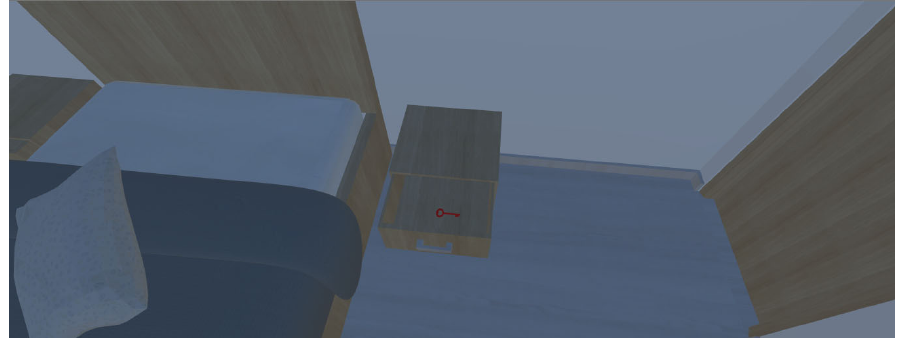
Figure 5. First exercise case in which the key is inside the